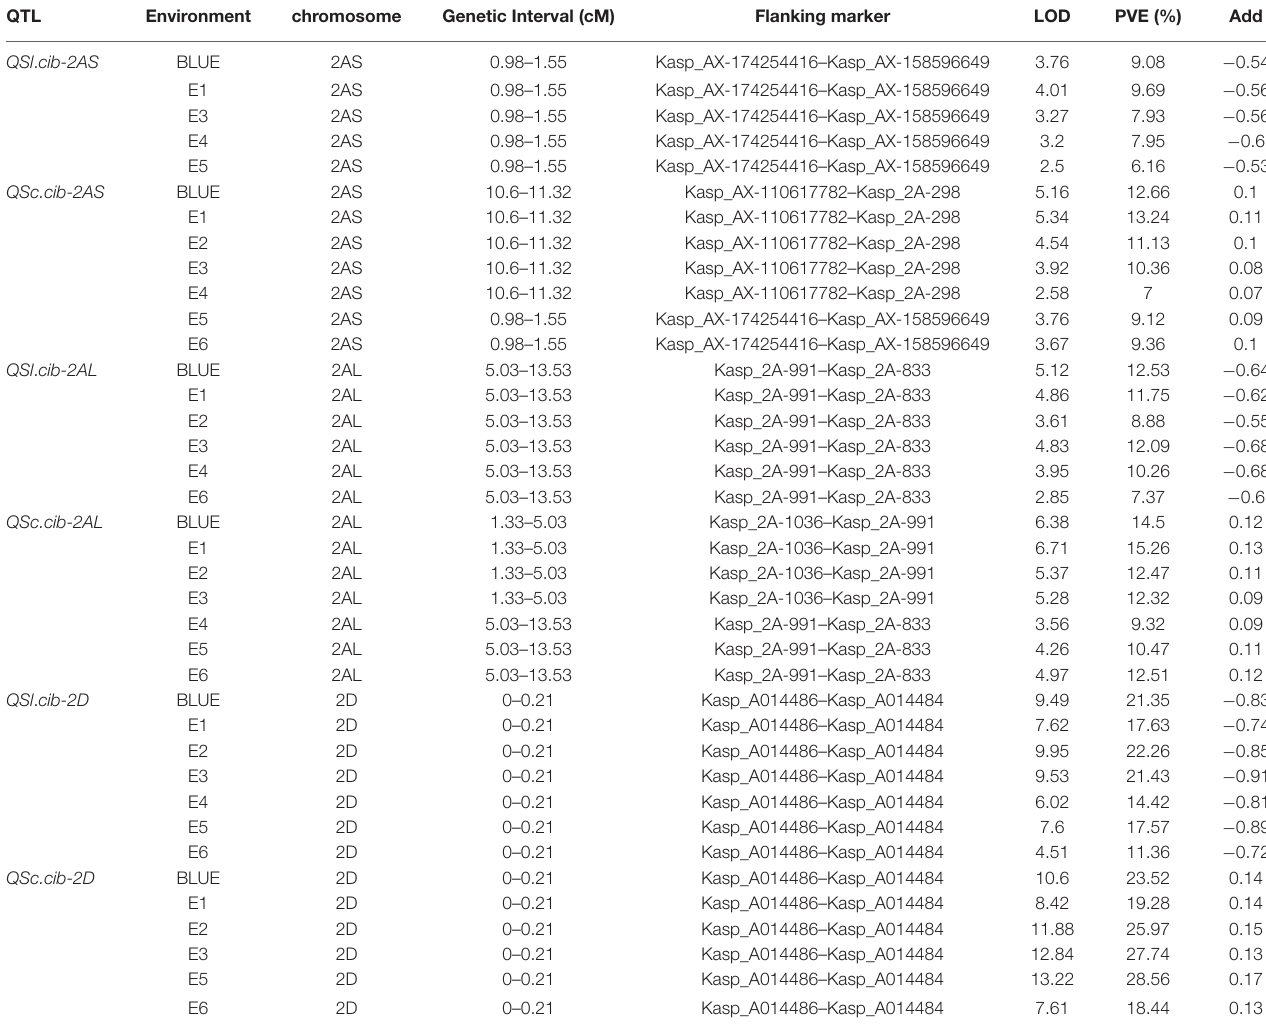
TABLE 2 | Quantitative trait loci (QTL) for spike compactness (SC) and spike length (SL) identified from the candidate region using BSE-Seq in different environments and the BLUE